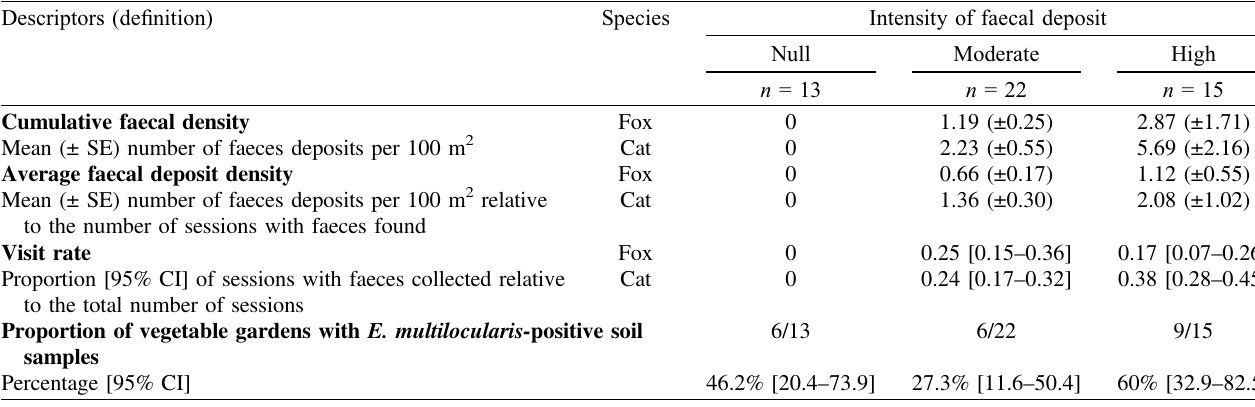
Table 2. Values for descriptors of fox and cat faeces deposits and proportion of vegetable gardens with at least one soil sample testing positive for Echinococcus multilocularis DNA in the three classes of intensity of faecal deposits.